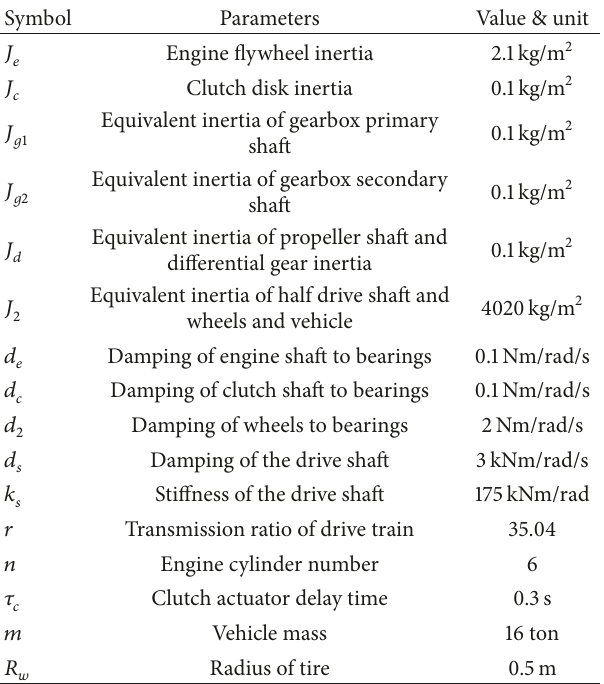
Table 1: Normal values of parameters of simulation